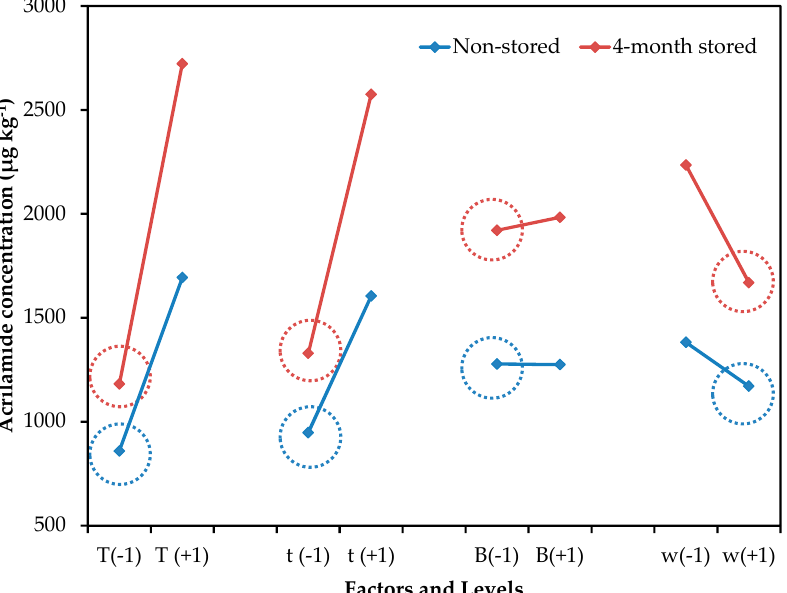
Figure 1. Mean e ff ect graph vs. acrylamide concentration ( µ g kg − 1 ) of the experimental design for Figure 1. Mean effect graph vs. acrylamide concentration (µg kg − 1 ) of the experimental design for non-stored and 4-month stored potato tubers storage. Molecules 2019 , 24 , x non-stored and 4-month stored potato tubers storage.